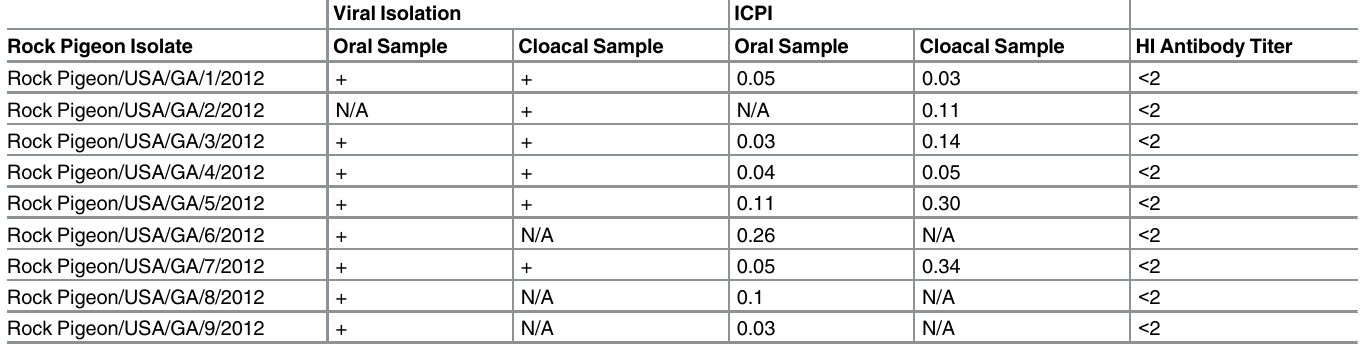
Table 2. Rock Pigeon virus isolation, HI antibody titer, and intracerebral pathogenicity indices (ICPIs). Field swabs collected from the oral and cloacal cavities positive for virus are listed with a + symbol, otherwise an N/A is listed. ICPI experimental infection swabs collected in the lab from the oral and cloacal cavities positive for virus are listed below with their corresponding ICPI values, otherwise an N/A is